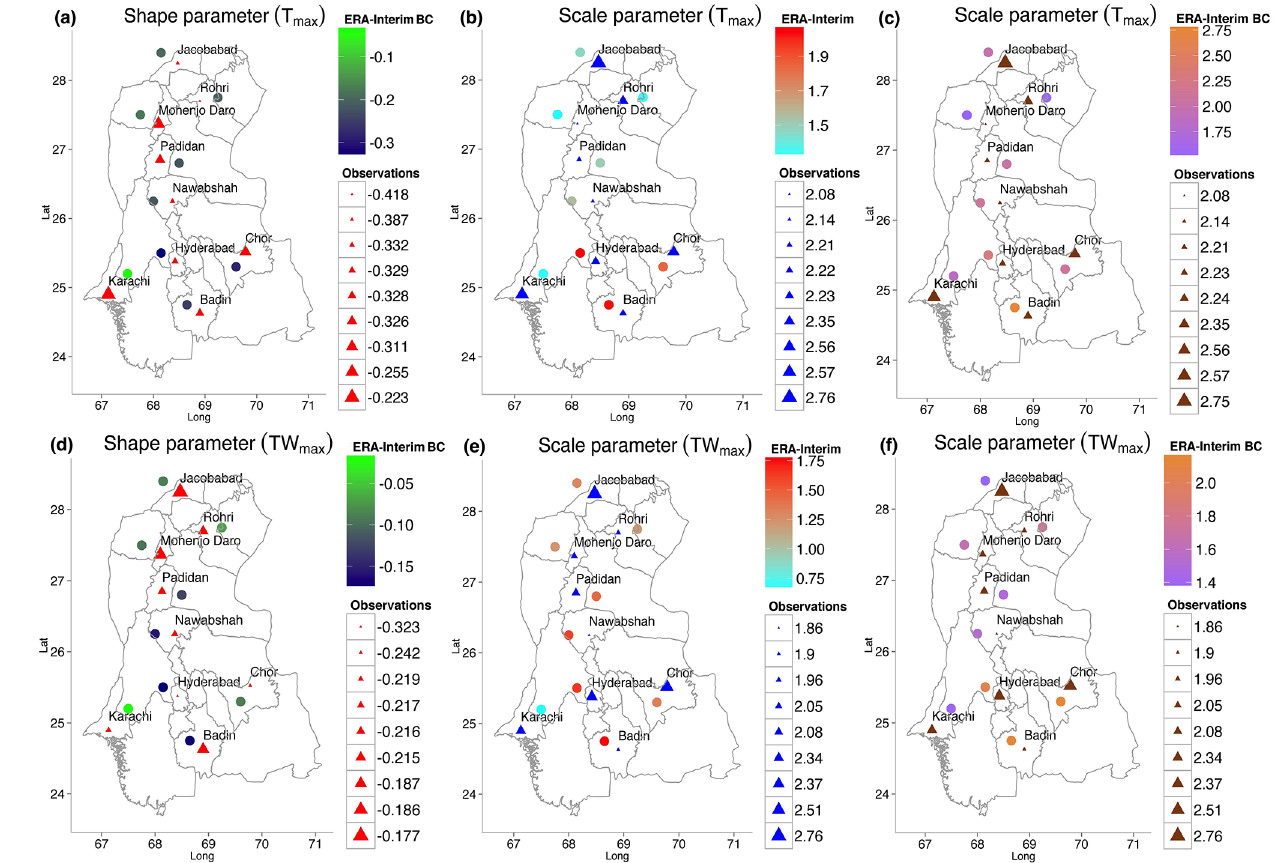
Figure 4. Spatial distribution of the shape parameters ξ and scale parameters σ of the station-observed data, ERA-Interim, and bias-corrected ERA-Interim T max (a–c) and TW max (d–f) ( ◦